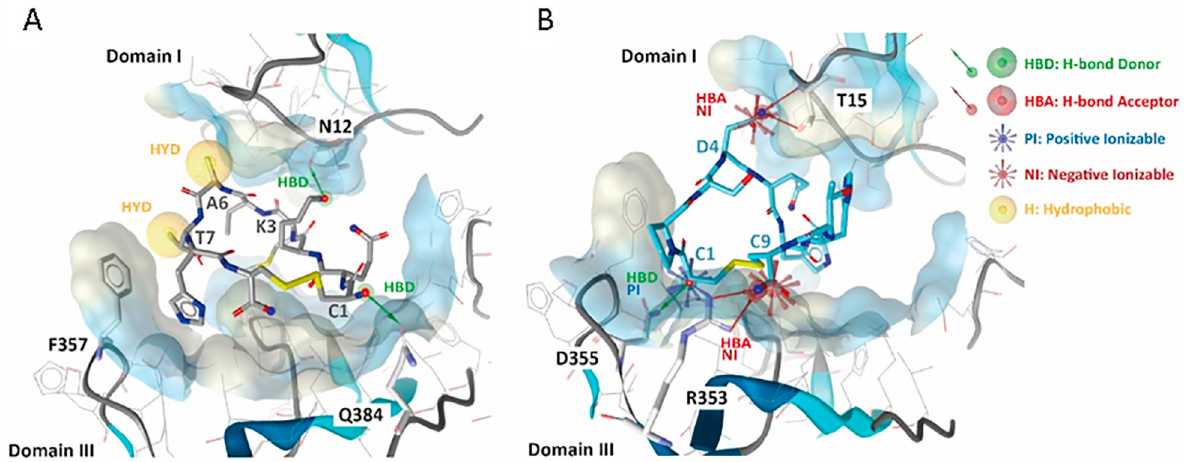
Figure 3. Principal amino acid (aa) interactions involved in the binding site of EGFR between 01_cys EGFR ( A ) and 06_cys EGFR ( B ) are labeled and highlighted in the stick model. On the right of the figure, the chemical pharmacophore features are explained. The EGFR cavity is shown in solid style. Table 1. HADDOCK and PRODIGY results of 01_cys EGFR and 06_cys EGFR—EGFR complexes.